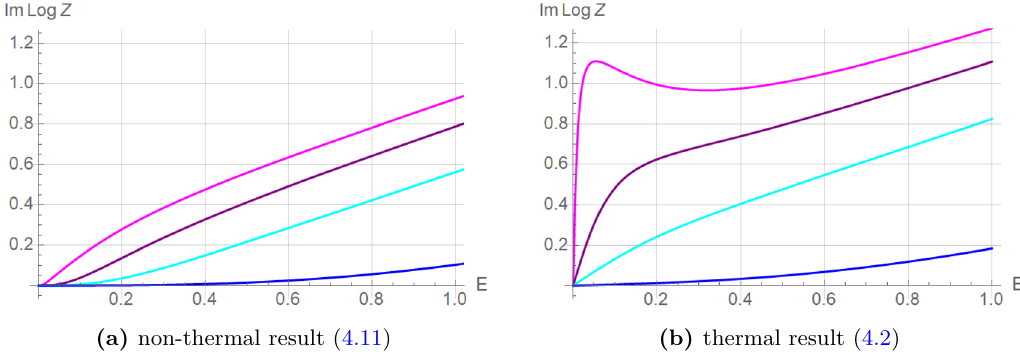
Figure 8. The vacuum non-persistence Im [log Z ] , as a function of the electric field E , at fixed mass m = 0 . 1 , 0 . 3 , 0 . 5 and 1 , from magenta to blue (top to bottom). The non-thermal results are always monotonic. The thermal enhancement is most clear at small field strength and for small masses it leads to the IR hyperconductivity noted in [25].